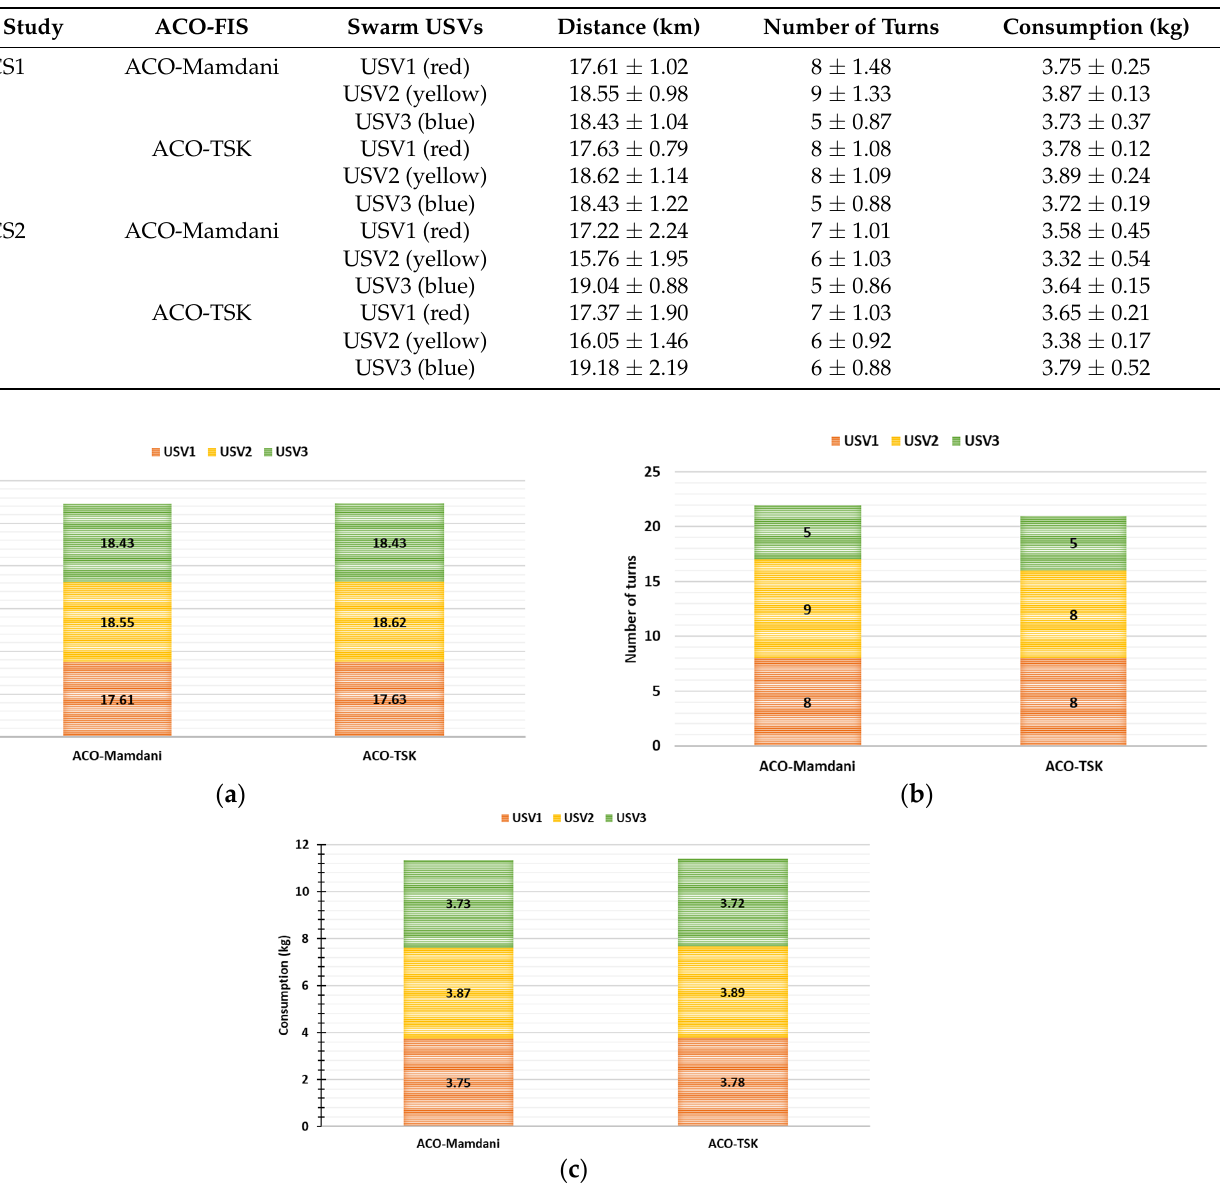
Figure 8. Cumulative results of ACO-Mamdani and ACO-TSK over the objective criteria: ( a ) distance; ( b ) number of urns; and ( c ) consumption for Case Study 1.